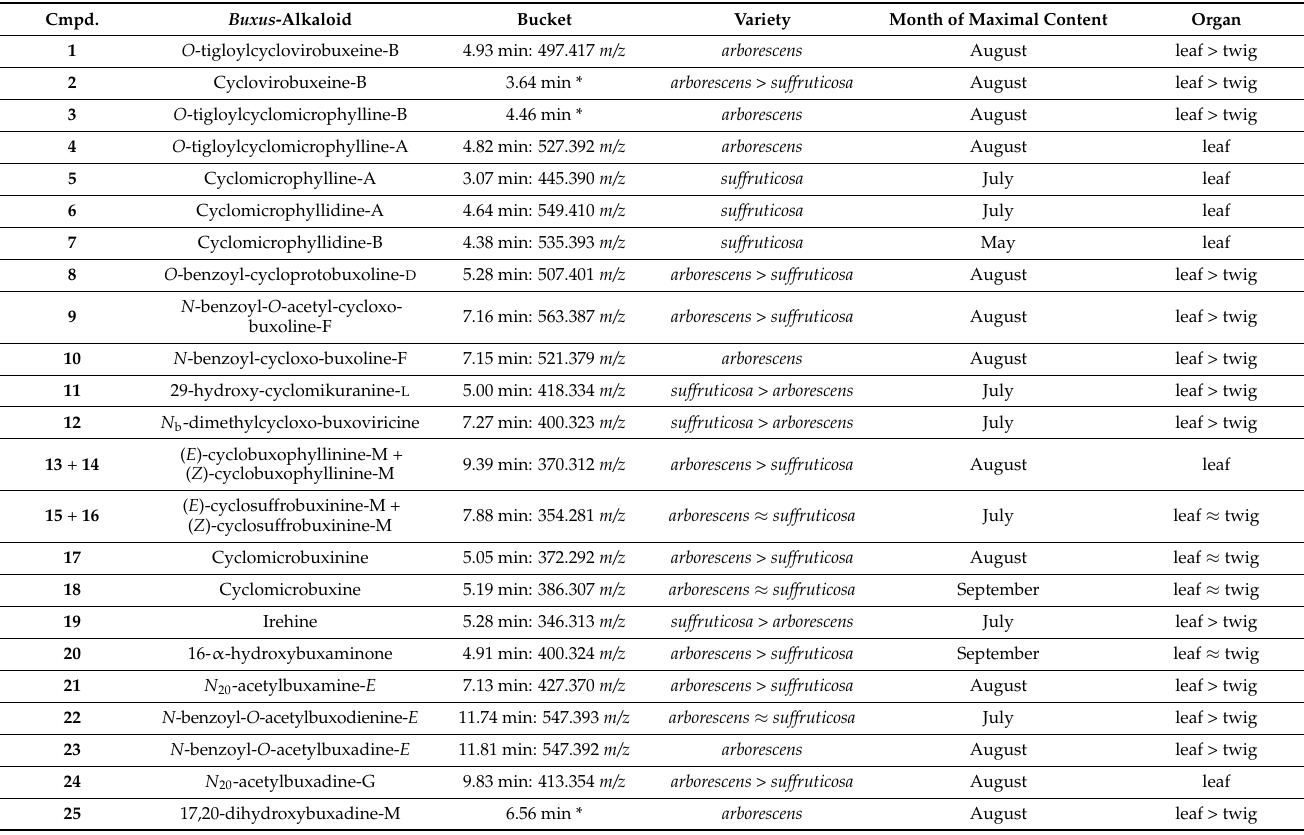
Cmpd.: compound; * Compounds 2 , 3 and 25 were not represented as buckets in the bucket table, so the occurrence of these alkaloids in the different extracts was evaluated via extracted ion chromatograms (EICs) for the